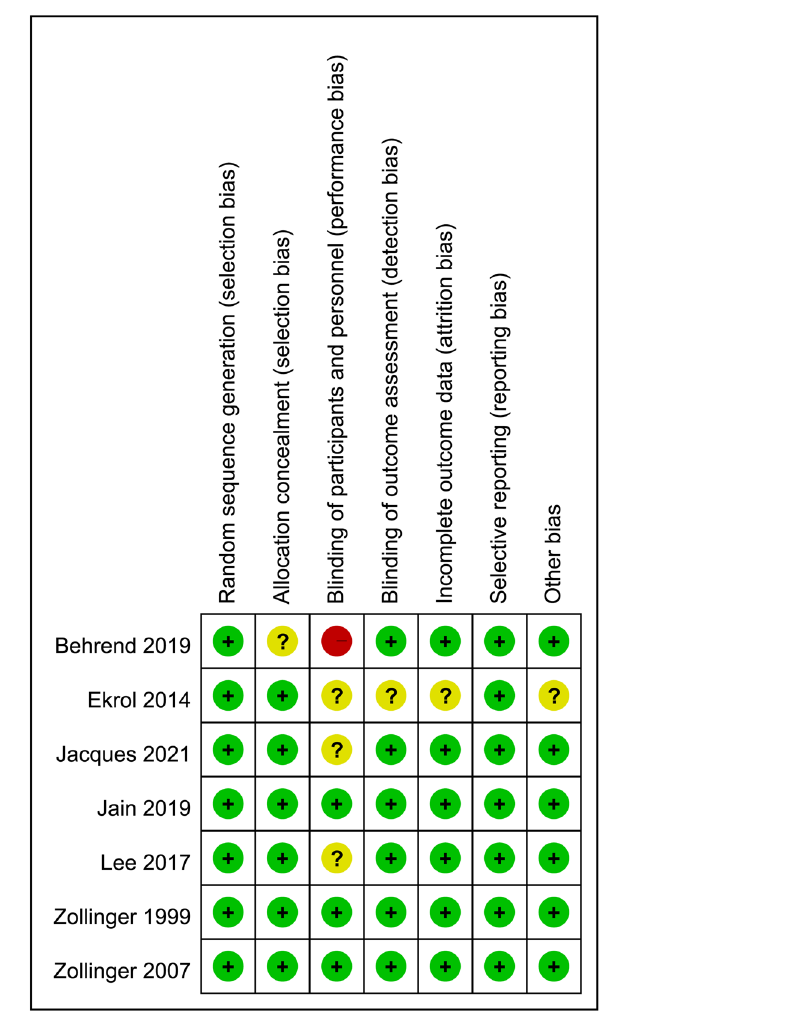
Figure 2. Risks of bias of individual